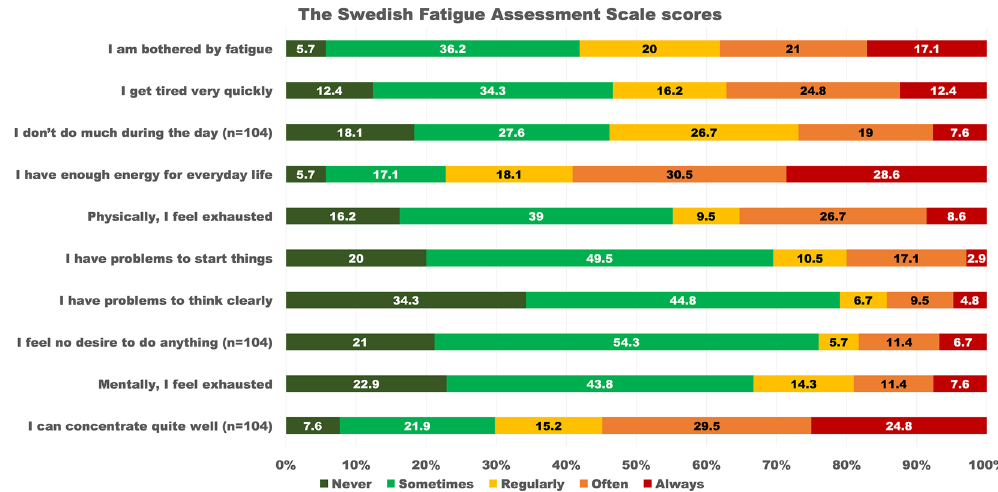
Figure 2. Proportions of the Swedish Fatigue Assessment Scale (S-FAS) scores of the study population. The original scores are presented also for items 4 and 10.